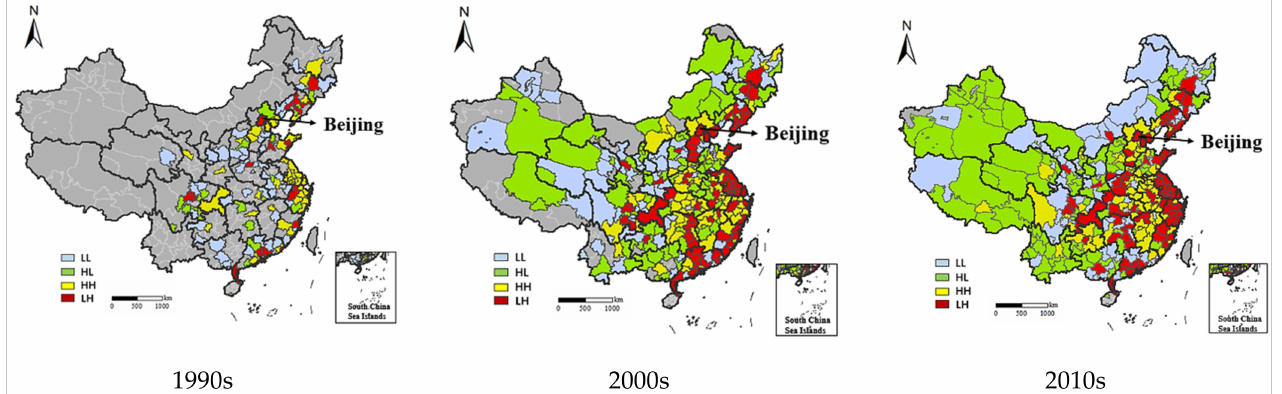
Figure 7. The spatial distribution of Chinese inter-city network nodes’ potentials in the 1990s, 2000s, and